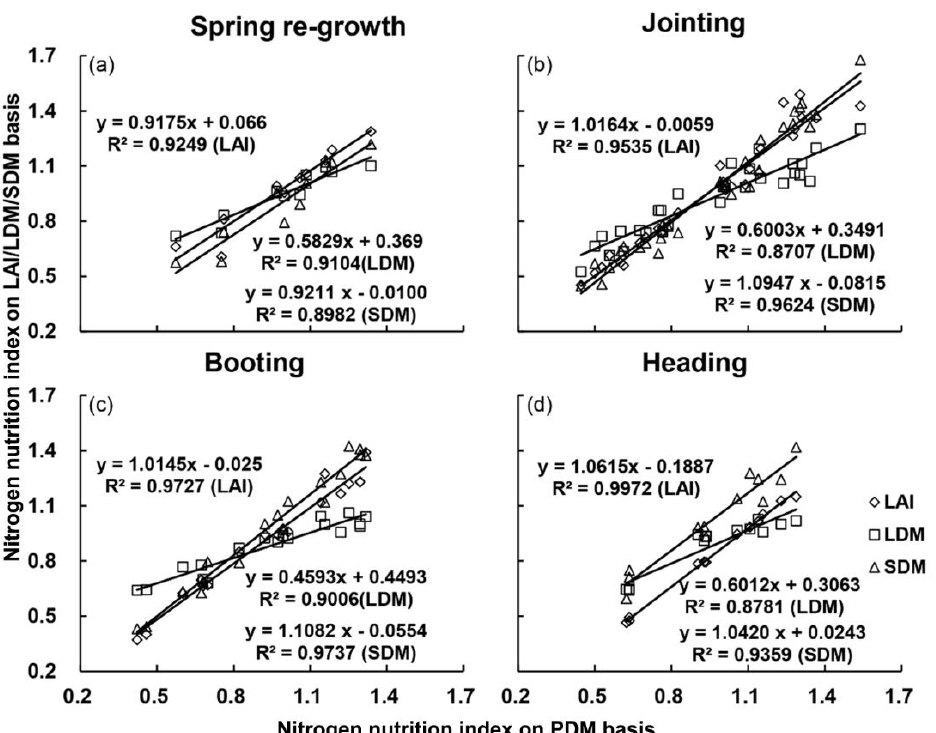
Figure 2. The relationships about nitrogen nutrition index (NNI) between plant dry matter based and leaf area index, leaf dry matter, and stem dry matter based at different growth stages ( a – d means relationship between PDM basis NNI and other indicators based NNI in different growth stages).